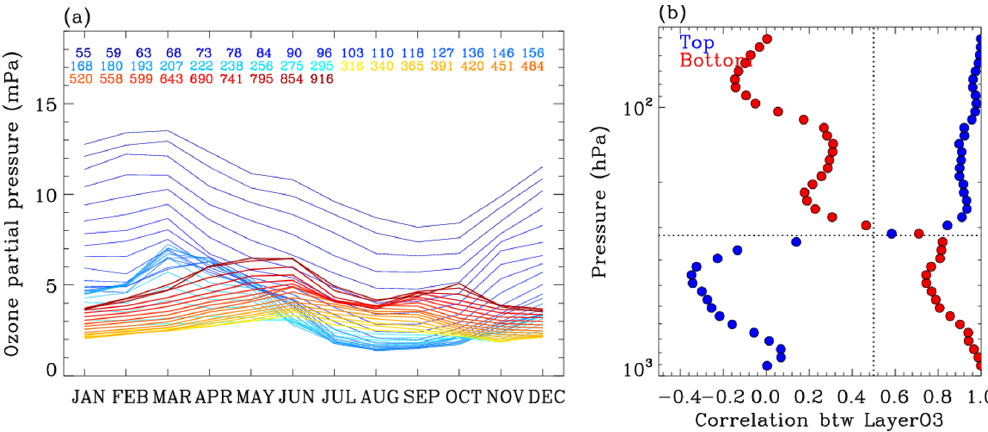
Figure 4. (a) Monthly variations of layer ozone partial pressures from ozonesonde soundings obtained from Pohang during the period of 2005 to 2020. The legend values indicate the midpoint pressure of the layer (hPa). (b) Correlation coefficients of monthly ozone variations between each layer and the bottom layer (916hPa in red) and between each layer and the top layer (55hPa in